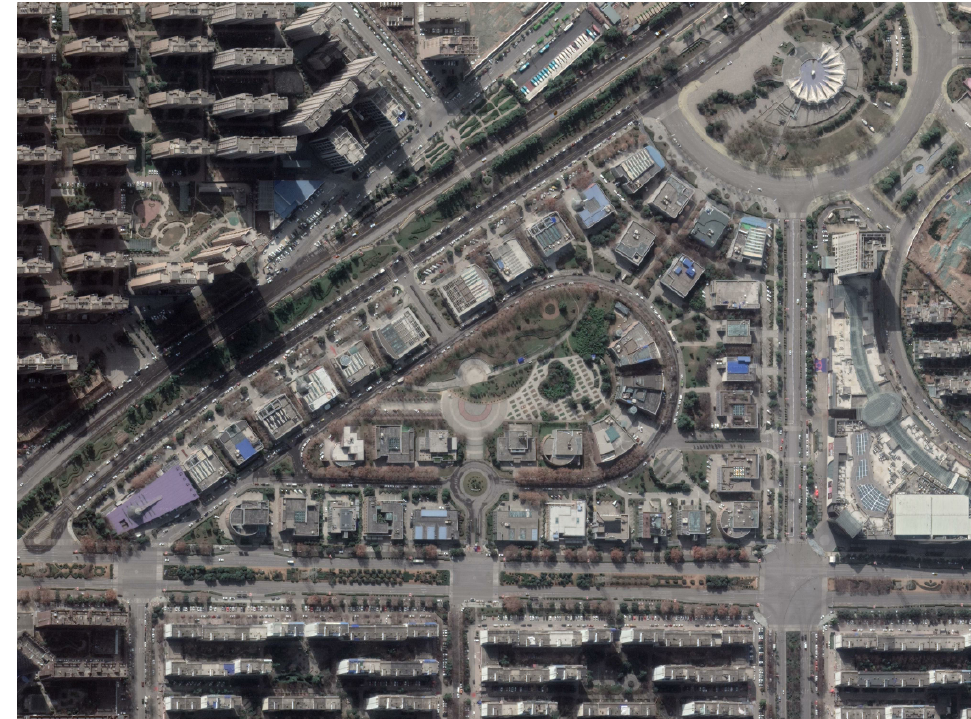
Figure 13. Reference satellite image download from Google Earth.